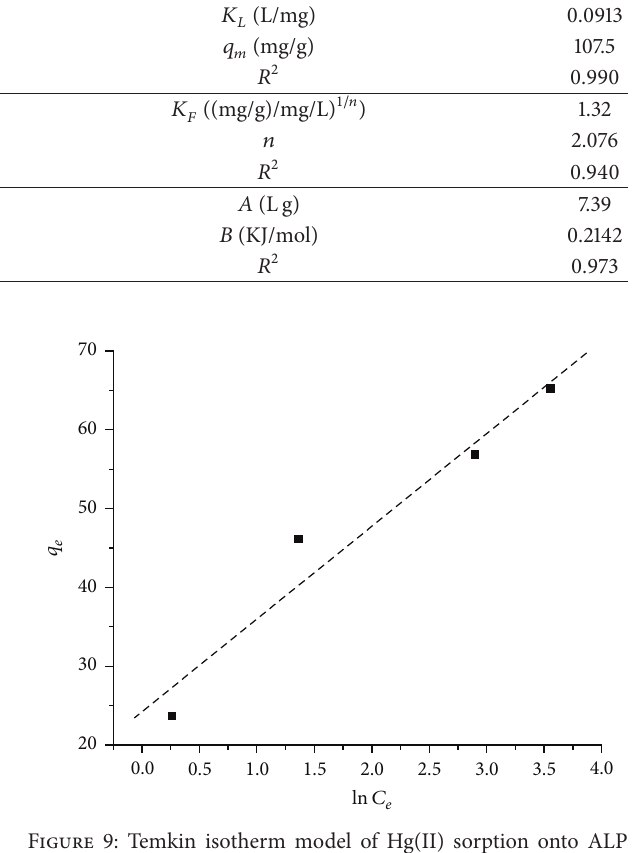
Figure 8: Freundlich isotherm model of Hg(II) sorption onto ALP biomass (at 303 K, pH 6.0).